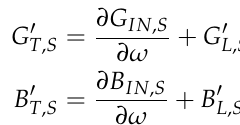
Figure 8. Output power sweep result of the active circuit in Figure 5 using the LSNA at the frequency f S . The black dot indicates the operating amplitude A S used for G (cid:48) and B (cid:48) 4.2. G (cid:48) T , S T , S